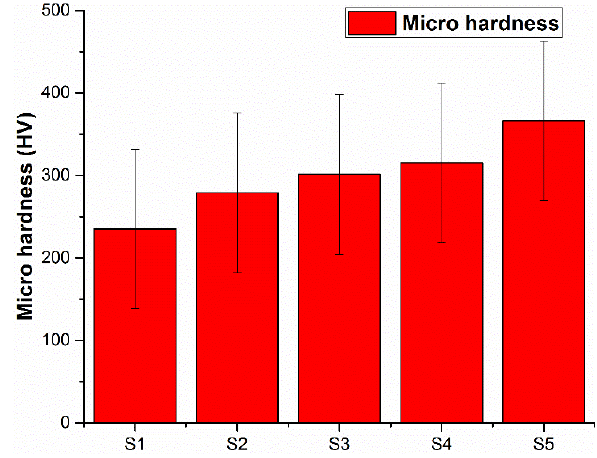
Figure 6. Micro hardness of all specimens.